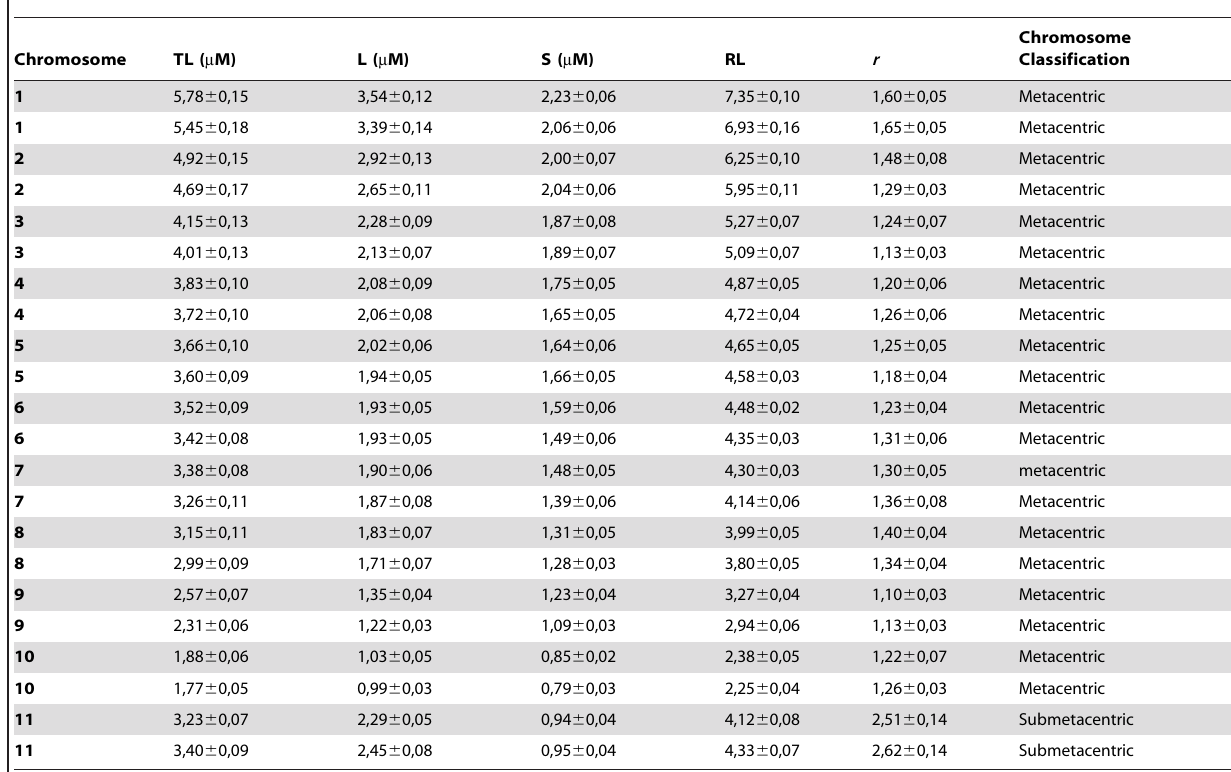
Table 1. Morphological analyses of the chromosomes of Acromyrmex striatus .